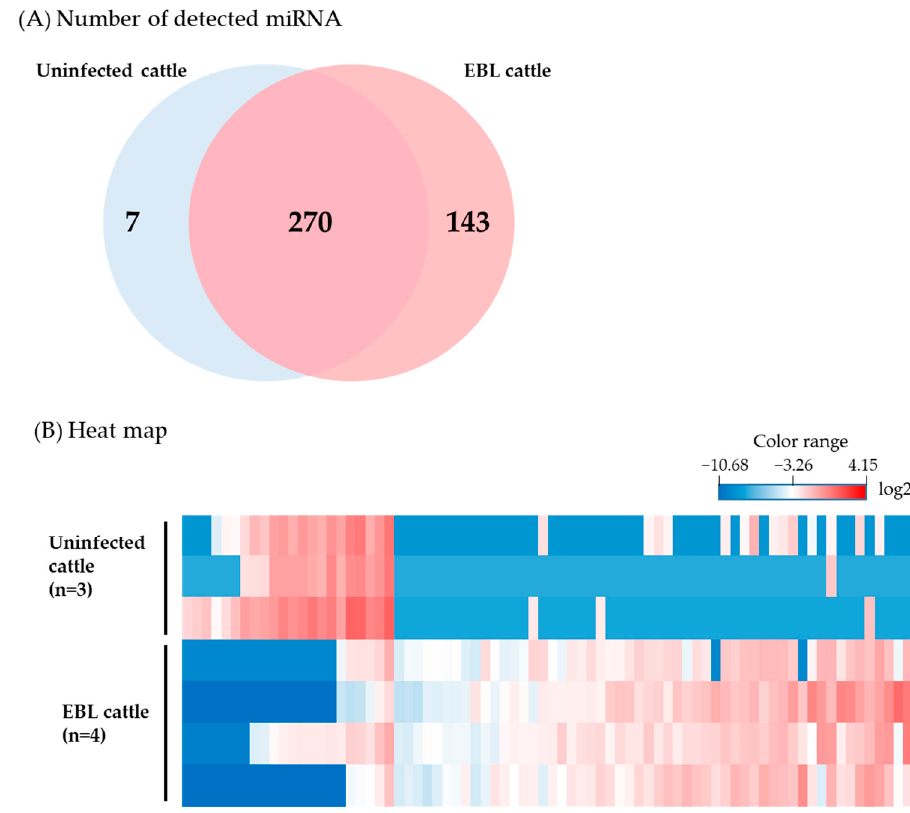
Figure 2. Microarray analysis. ( A ) Numbers of miRNAs detected using the microarray analysis. The number of miRNAs common in the uninfected and enzootic bovine leukosis (EBL) cattle was 270. The number of unique miRNAs in uninfected and EBL cattle were 7 and 143, respectively. These numbers include miRNAs that were detected in only one cattle among three or four cattle. The 143 miRNAs detected only in EBL cattle were not selected for further experiments to explore candidate biomarkers because the coefficient of variation (CV) was > 50%. ( B ) Heatmap of miRNAs detected using the microarray analysis. The microarray data were analyzed using the GeneSpring GX software. Color- coded scale bar represents relative levels of miRNAs ( ≥ 5-fold